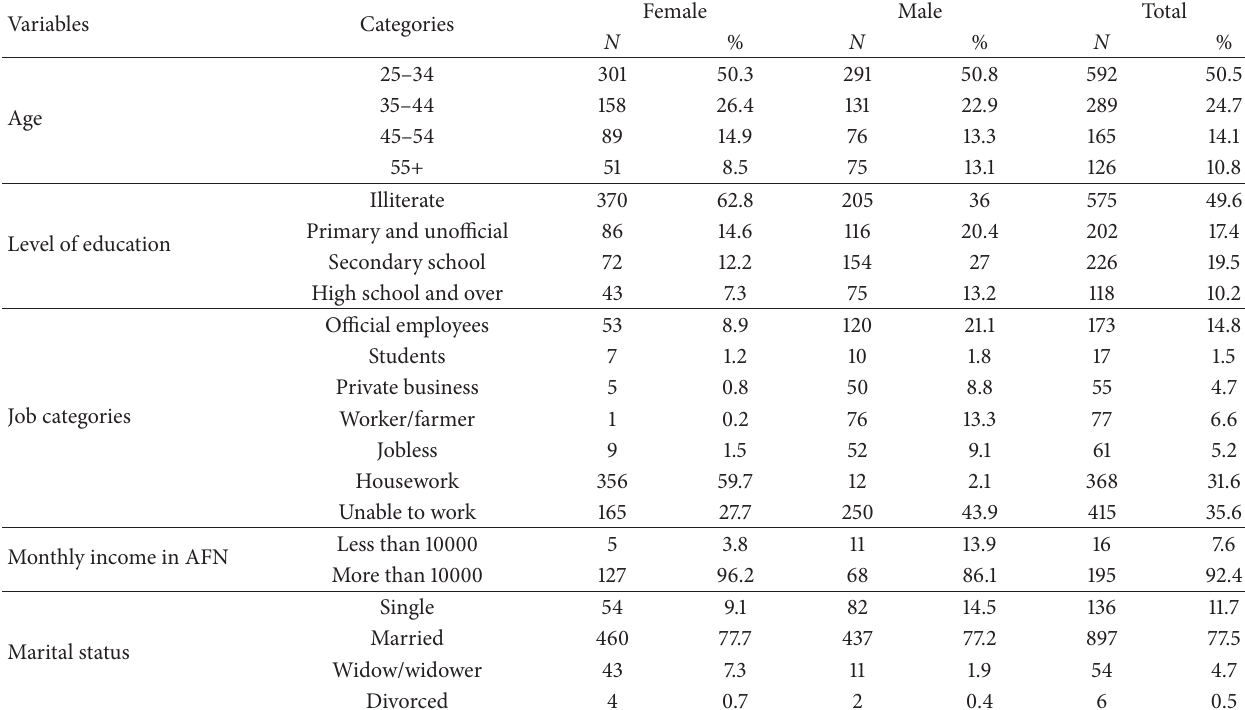
Table 1: Frequency distribution of demographic characteristics of the study participants, Kabul city ( 𝑁 = 1172 ).